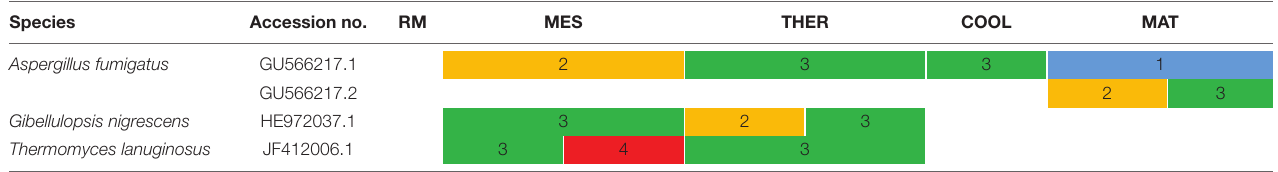
TABLE 3 | Thermal phenotypes of thermophilic lignocellulolytic fungal strains with same accession number detected at the different composting stages: RM, raw material; MES, mesophilic; THER, thermophilic; COOL, cooling; FP, final composting product. Species Accession no.